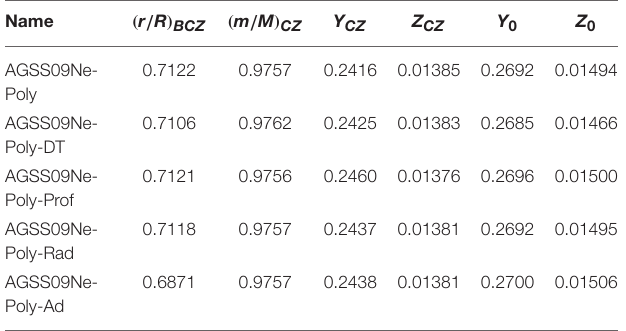
TABLE 4 | Parameters of the solar models with modified opacities and additional mixing used in this study.